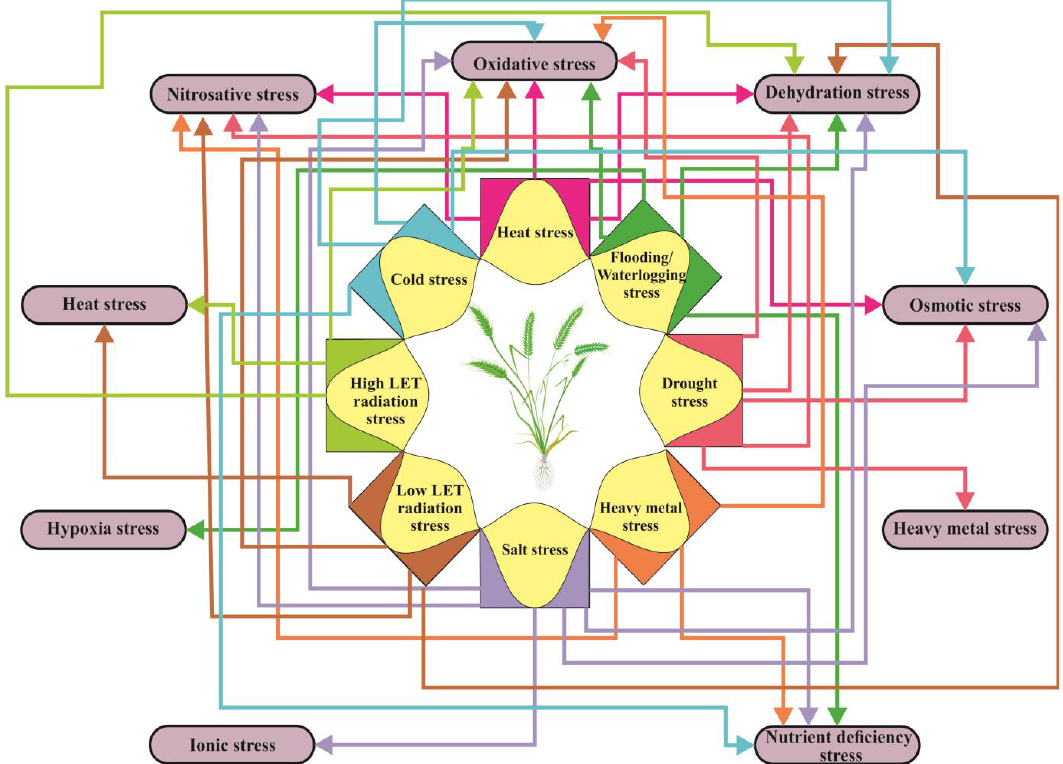
Figure 3. A simplified illustration of the interaction between plant responses induced by primary abiotic stress factors and those caused by secondary and tertiary stressors. The primary stress factors are indicated in the inner section of the figure, while the secondary and tertiary stressors are shown in the outer section. The arrows depict the relationship between the various stressors.